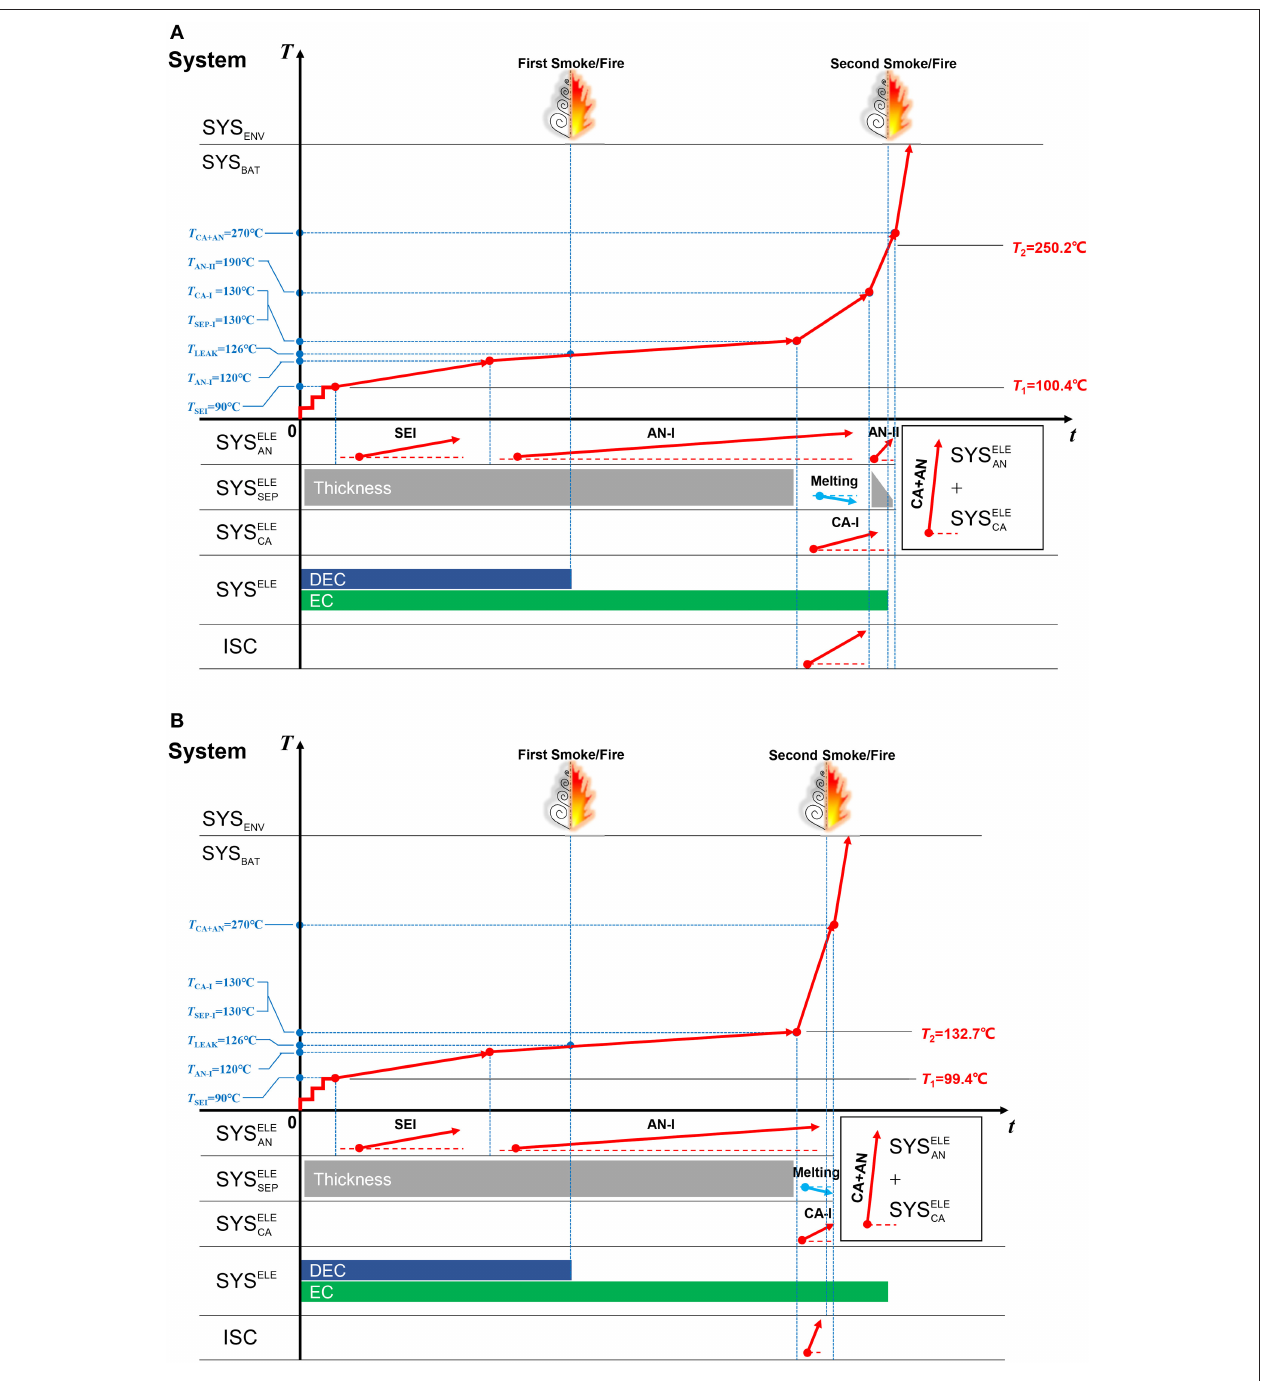
FIGURE 13 | The TSM for interpreting two different ARC test results for Battery Sample B. (A) The TSM for Case A, (B) The TSM for Case B.